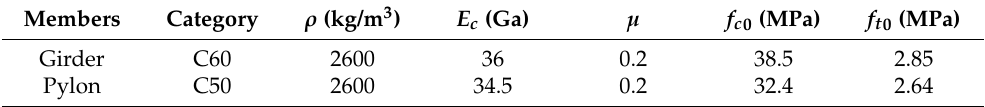
Table 2. Material properties of the concrete [58].